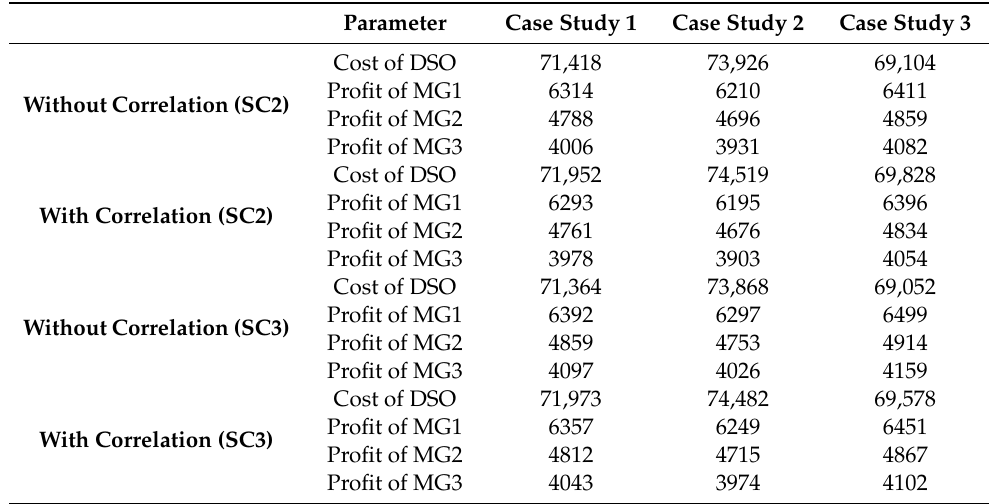
Table 3. Calculation time for large-scale test